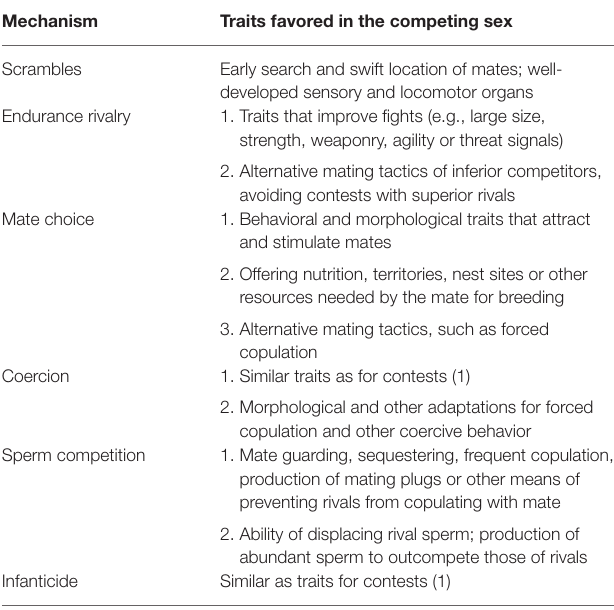
TABLE 1 | The different mechanisms of sexual selection and the traits they favor in the competing